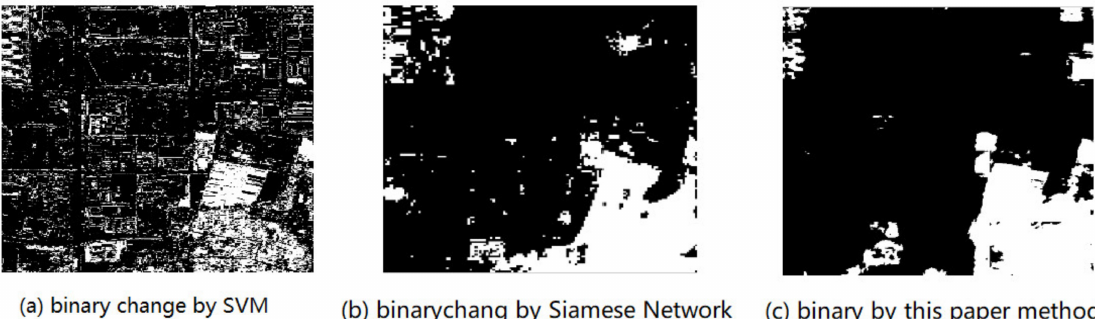
Figure 19. Comparison of three change detection